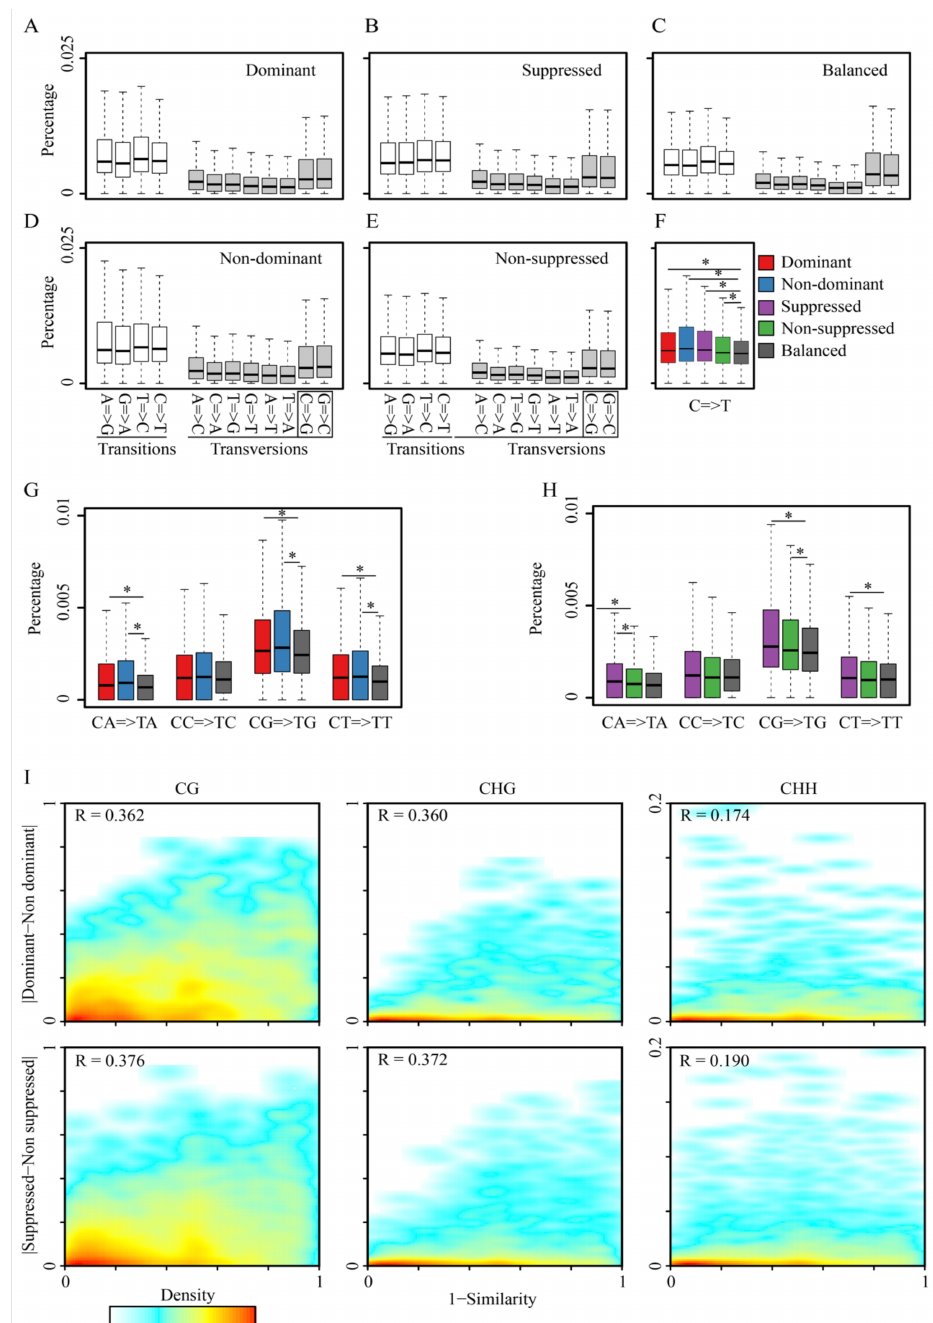
Figure 4. The mutation rate of cytosine is associated with DNA methylation. The box plot showing the mutation rate comparison of the single-nucleotide mutation of orthologous gene pairs between sugarcane and sorghum of different categories tetrads. Dominant ( A ), suppressed ( B ), balanced ( C ), non-dominant ( D ), non-suppressed ( E ). ( F ) Comparison of C<=>T substitution rate between balanced and non-balanced alleles. Non-balanced alleles were divided into dominant, non-dominant, suppressed, and non-suppressed alleles. ( G , H ) Comparison of the substitution rate of different mutation types between balanced and dominant/non-dominant alleles ( G ) and suppressed/non- suppressed alleles ( H ). The mutation types were separated according to cytosine 3 (cid:48) neighboring nucleotide. The differences were tested using the Mann–Whitney test. * p value < 0.05. ( I ) The relationship between genetic variation and changes in DNA methylation in differentially expressed homologous